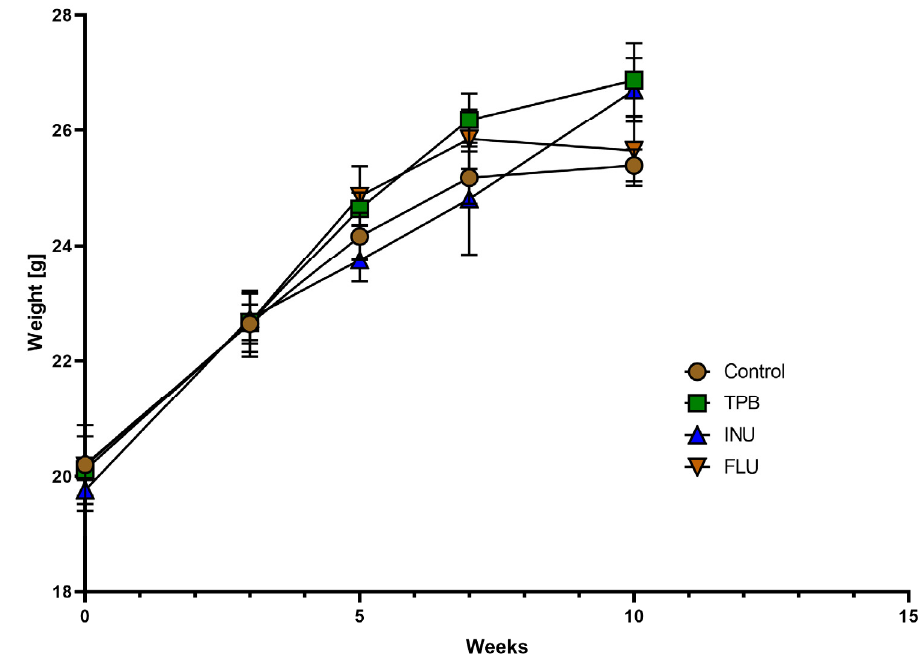
Figure 3. Effect of TPB, INU, and FLU on the body weight of mice. TPB—topinambur; INU—inulin; FLU—fluoxetine. Each bar represents the mean for seven mice; error bars are S.E.M.